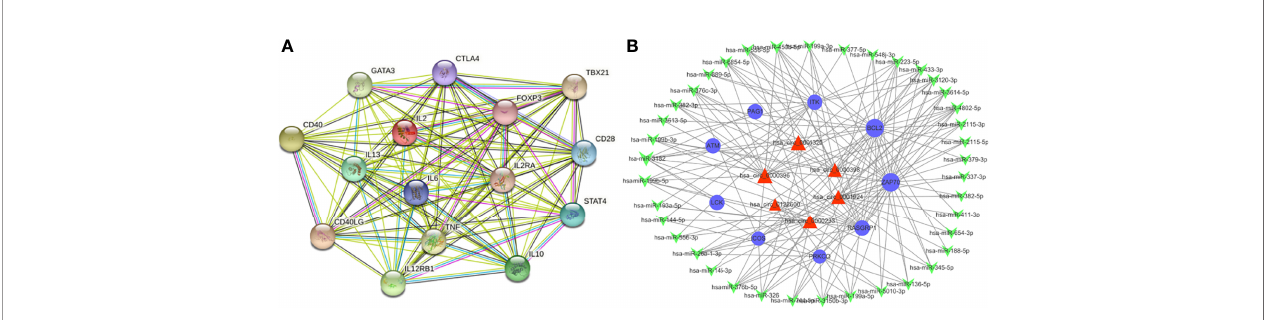
FIGURE 7 | Overview of the networks. (A) The PPI network of differently expressed mRNAs based on the STRING database. (B) Construction of circRNA-miRNA- mRNA ceRNA network based on the selected vital genes related to immune and in fl ammation. The ceRNA regulatory network includes 9 mRNAs, 39 miRNAs and 6 circRNAs. The blue circular nodes represent mRNAs, the red triangular nodes indicate circRNAs, the green arrow nodes